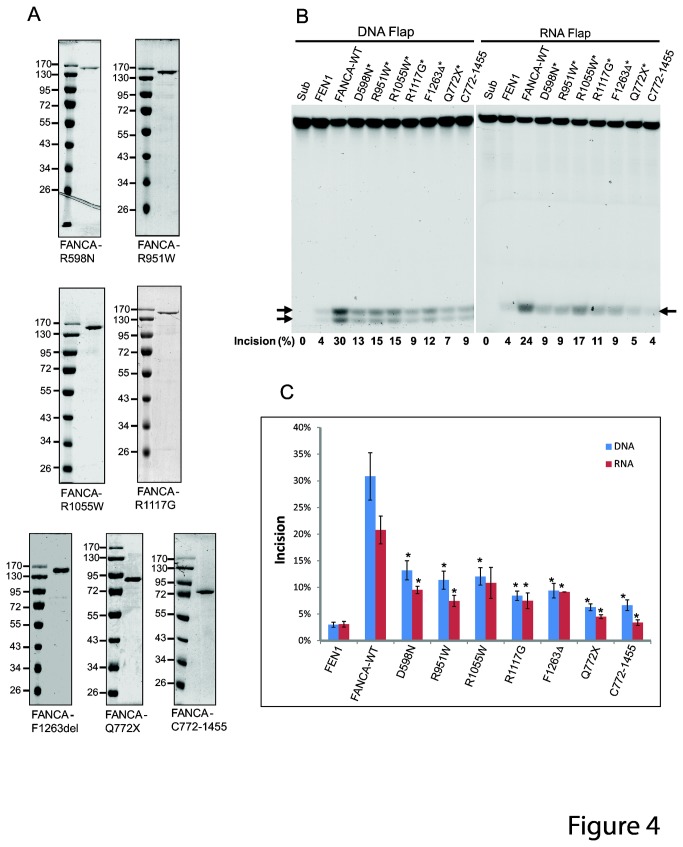
Pathogenic FANCA mutant proteins are inefficient in stimulating FEN1 endonuclease activity.(A) SDS-PAGE analysis of purified FANCA mutant proteins. Proteins were subjected to 10% gel electrophoresis and the gel was stained with Coomassie Brilliant Blue R-250. D598N, R951W, R1055W, R1117G, F1263del, and Q772X are pathogenic FANCA mutants. C772–1455 is C-terminal residues 772–1455 of FANCA. All peptides shown were tagged with hexahistidine at their N termini. Protein markers in kilodaltons were indicated on the left. (B) FEN1 endonuclease assays were performed with WT and mutant FANCA protein for both 15nt length DNA and RNA 5’ flap substrates. The concentration of FEN1 was 0.2 nM for DNA flap and 0.1 nM for RNA flap. The concentration of FANCA was 10 nM. Reaction products were resolved in 15% denaturing polyacrylamide gel. Arrows point to the incision products. The incision rate is quantified and shown on the bottom. (C) Quantitation of three independent FEN1 endonuclease assays in B by incision rate. Error bars represent stand errors. A paired t-test was performed to determine the statistical significance of FEN1 endonuclease activity between WT and mutant FANCA. *, p<0.05.